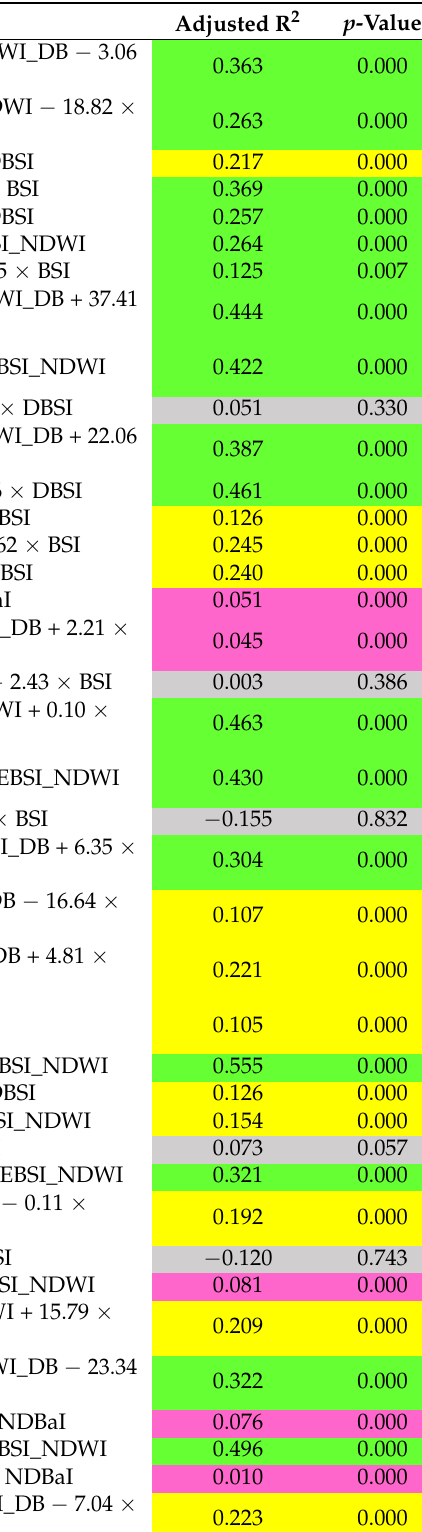
Table 5. Linear regression equations between the land surface temperatures and four optimal land- use/land-cover indices in eleven cities in typical global climatic zones during the daytime and nighttime in the summer and